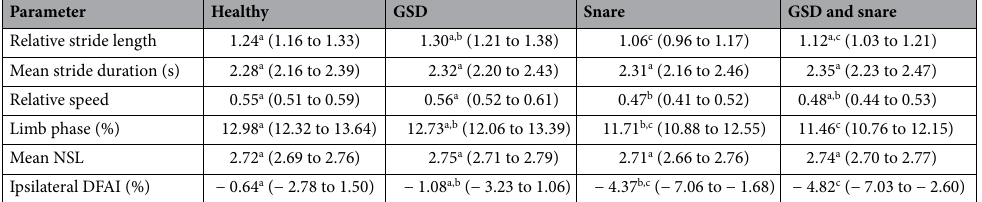
Table 5. Pairwise comparisons of estimated marginal means for spatiotemporal limb kinematics among different giraffe conditions in free-ranging Nubian giraffe ( Giraffa camelopardalis camelopardalis ). Parentheses contain 95% confidence intervals. Shared superscripts within a row indicate that estimated marginal means were not significantly different.